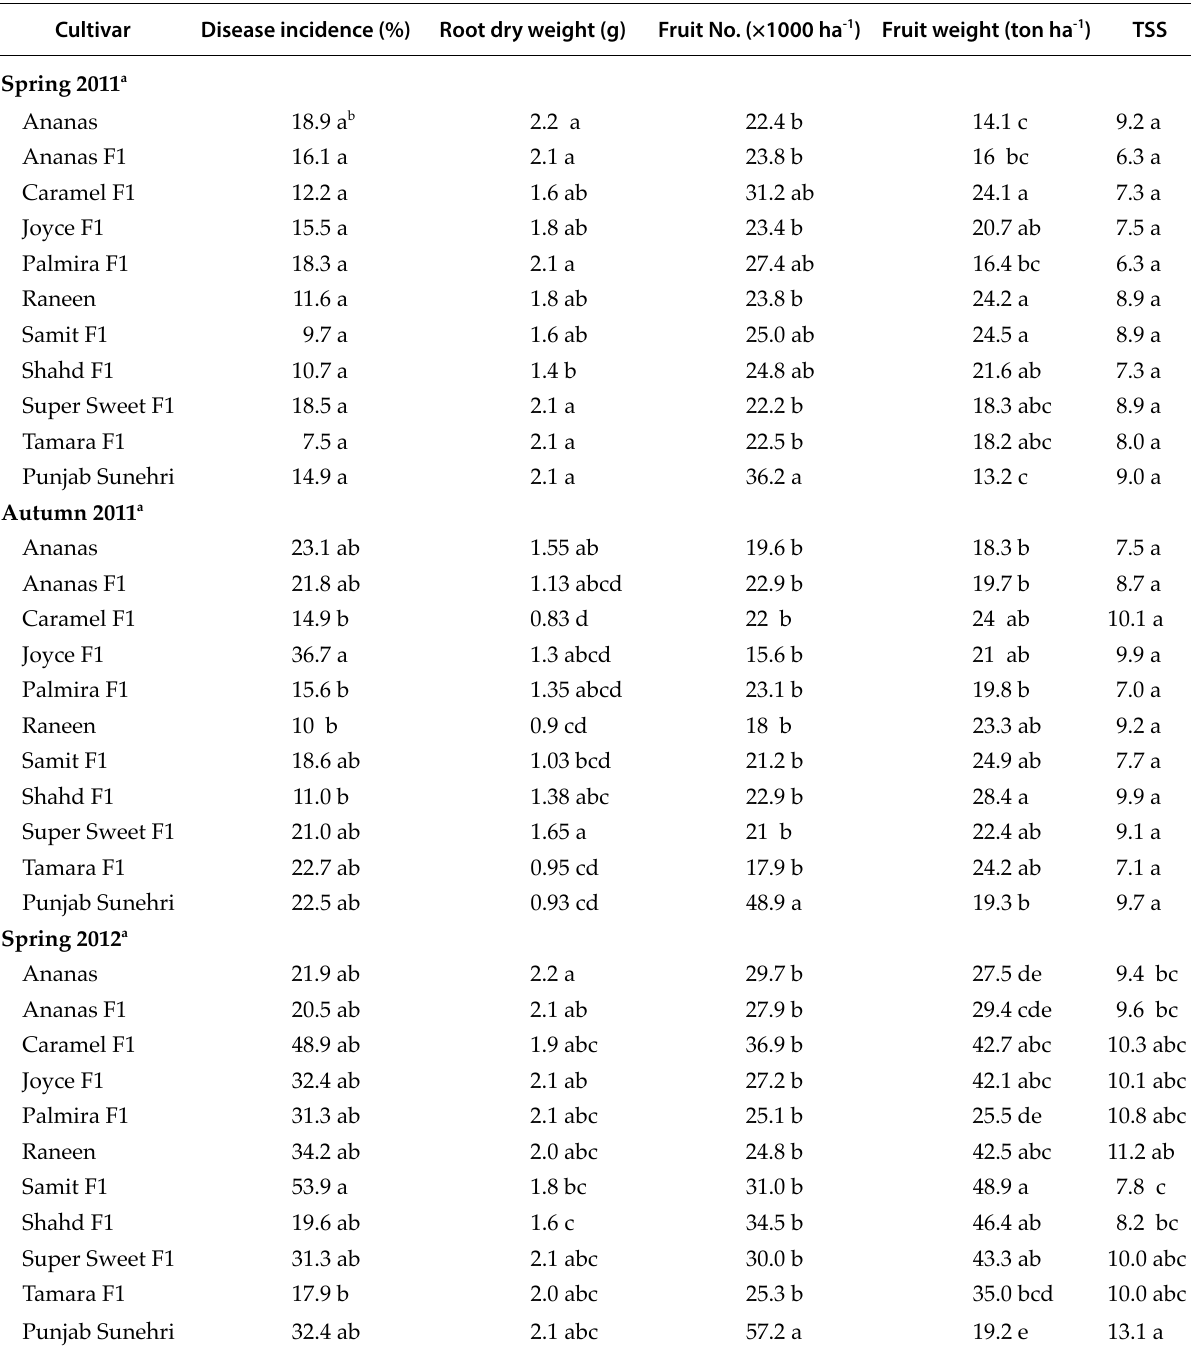
Table 4. Field evaluation of 11 muskmelon cultivars for reaction to vine decline, growth, yield and total soluble solids (TSS)